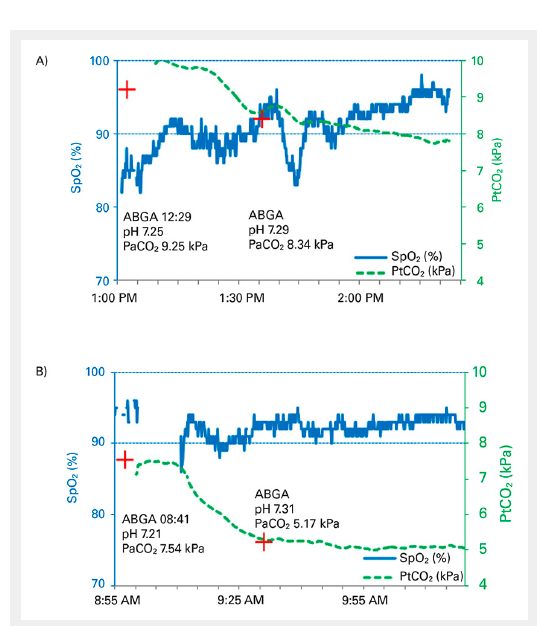
Table 1: Characteristics of patients at baseline.